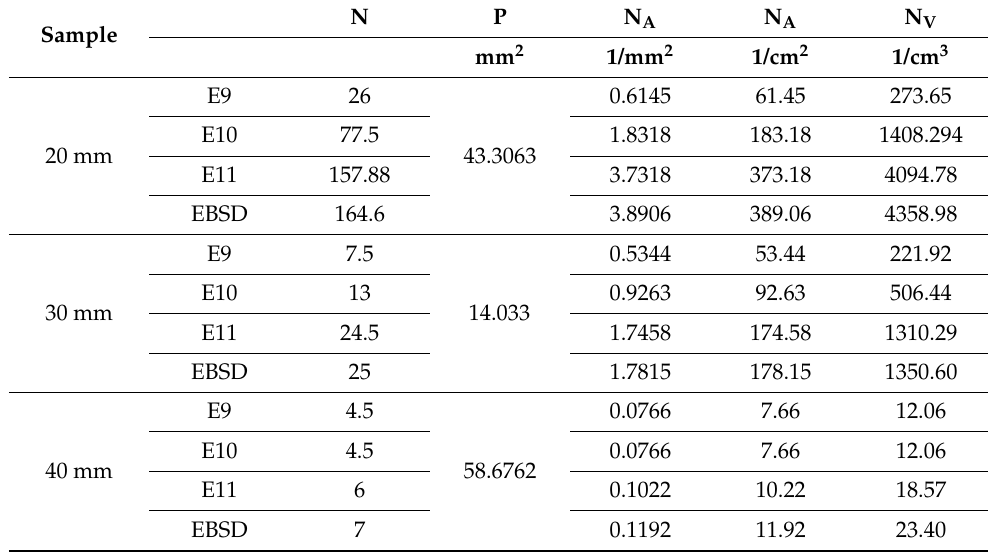
Figure 9. Phase and grain orientation scale. Table 4. Data and results for calculating numbers of N A and N V grains.